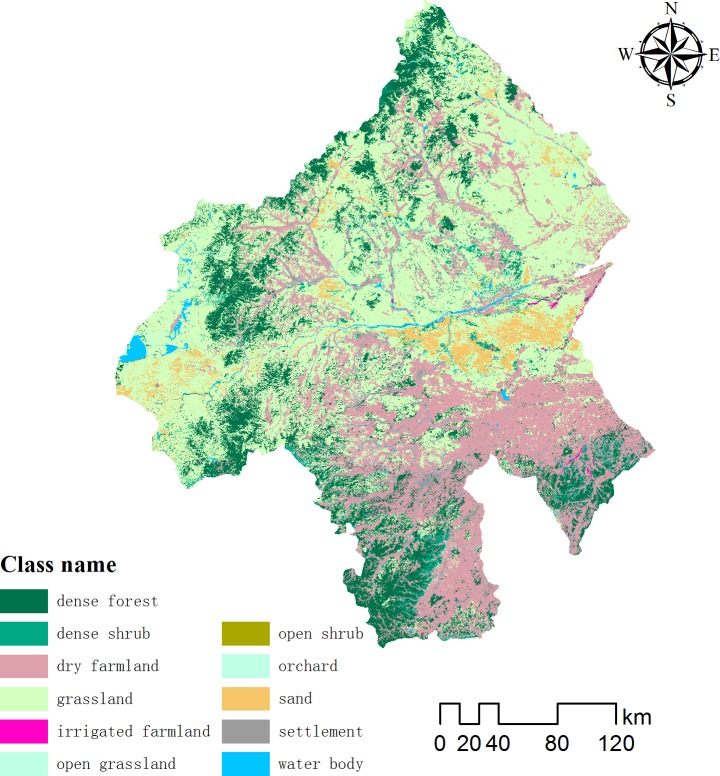
Map of land use for the study area.